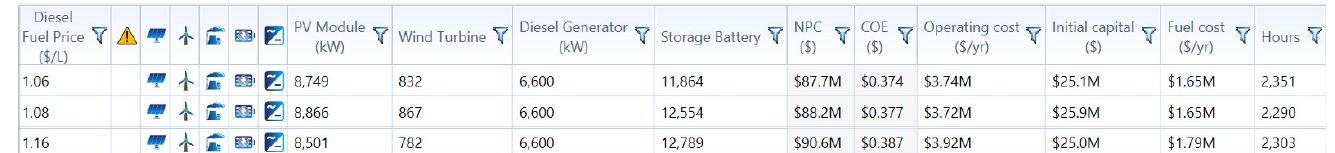
Figure 16. Impact of fuel price change on system costs.